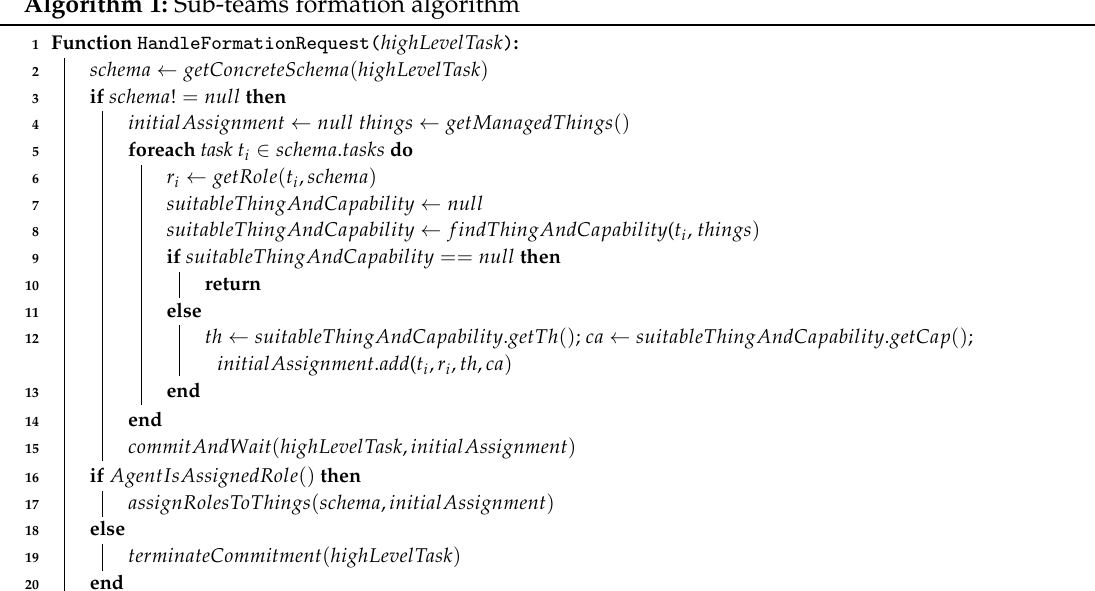
Algorithm 1: Sub-teams formation algorithm